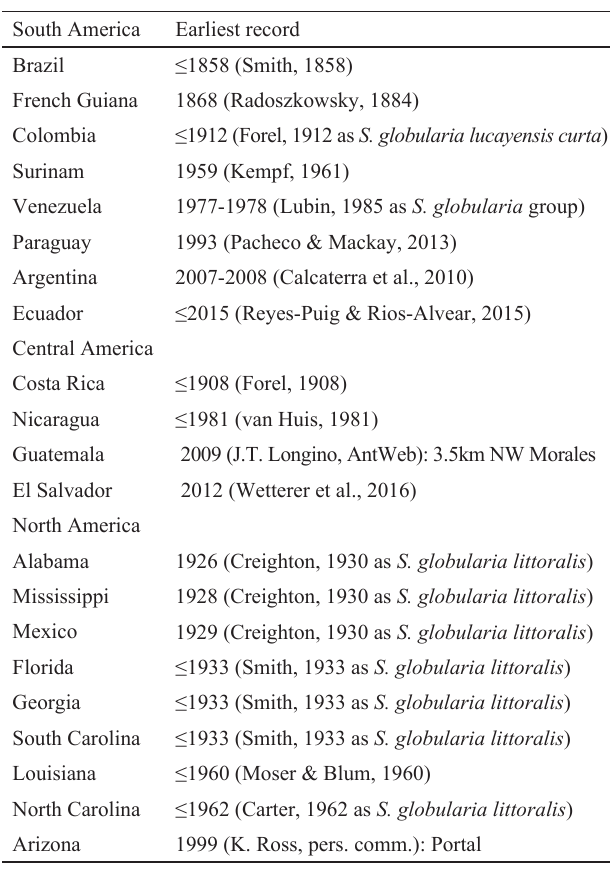
Table 1 . Earliest known continental records for Solenopsis globularia in the New World. Unpublished records include collector, source, and